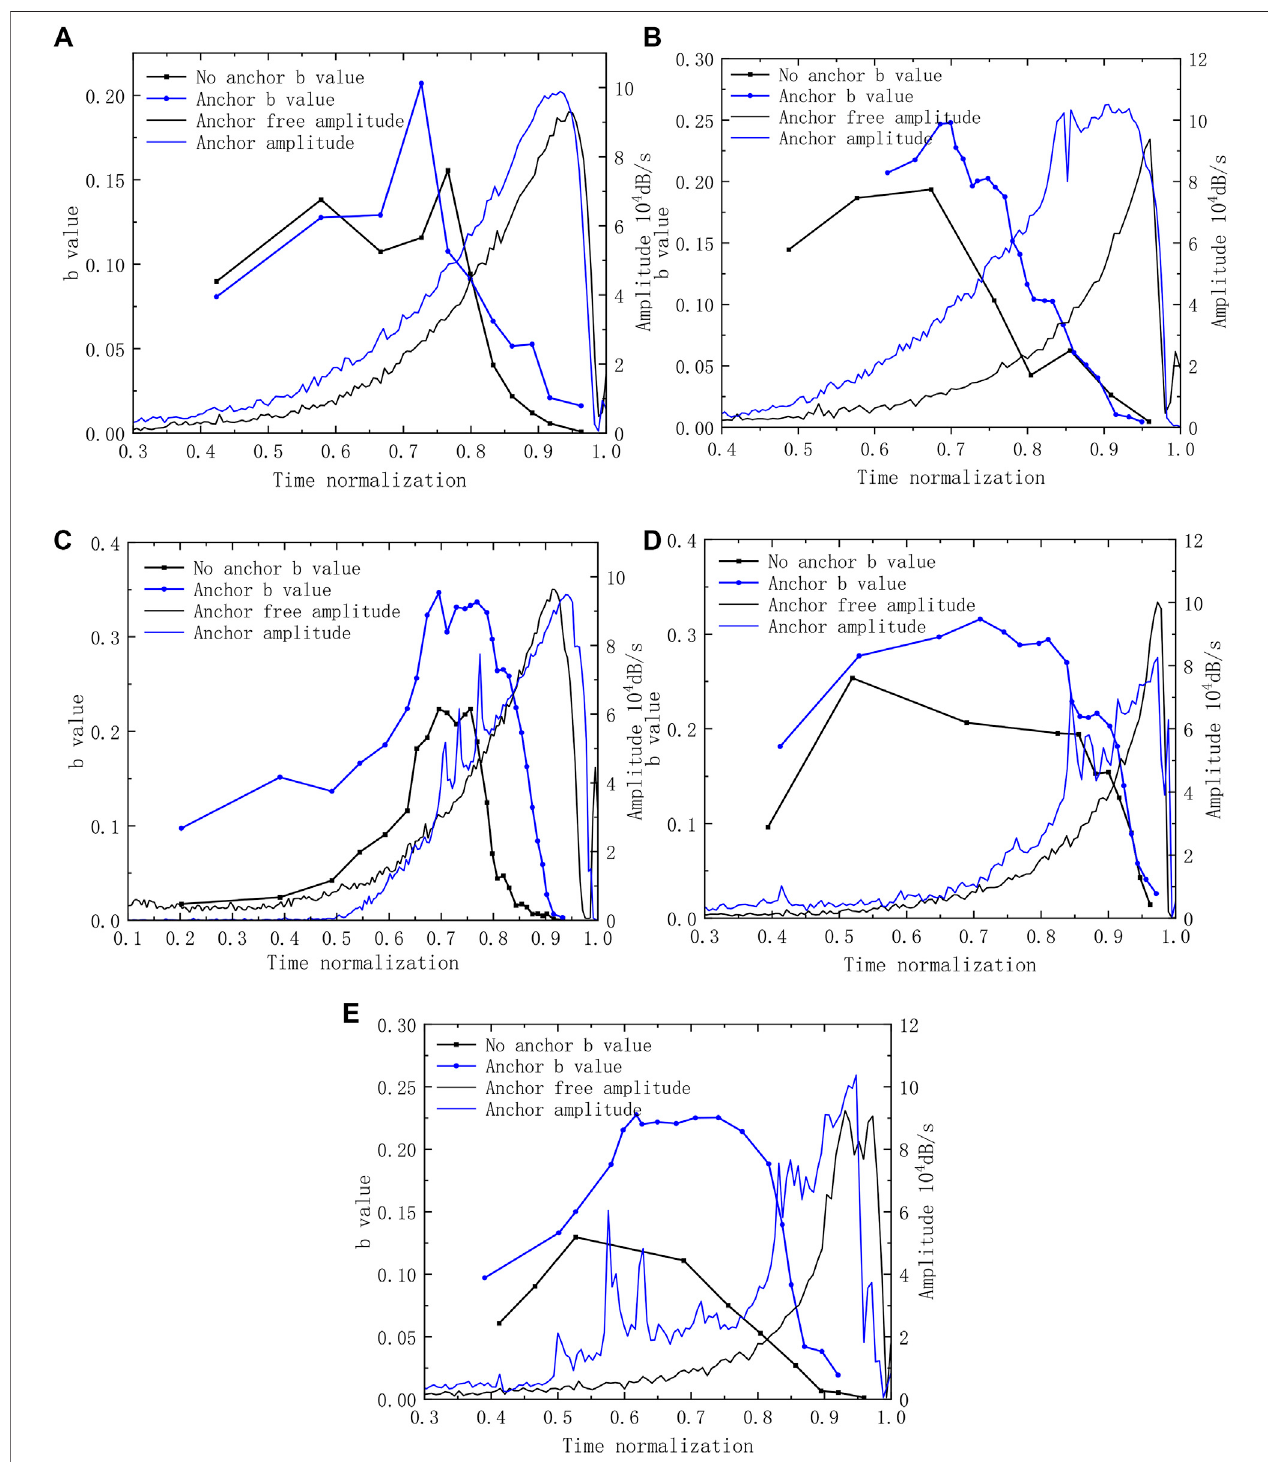
FIGURE10| Relationshipbetweenbvalueandamplitudeoflayeredsandstone: (A) 0 ° sandstone; (B) 30 ° sandstone; (C) 45 ° sandstone; (D) 60 ° sandstone; (E) 90 ° sandstone.